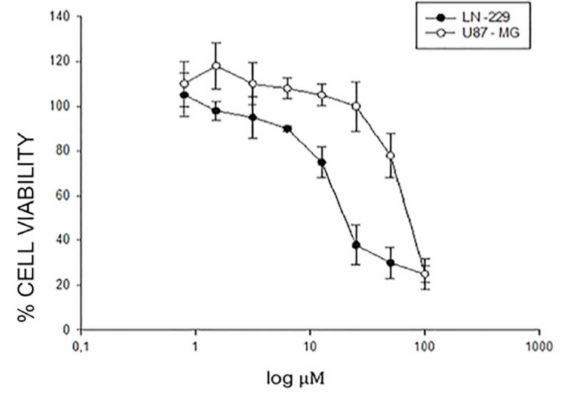
Figure 1. E ff ects of EA100c red on cell growth